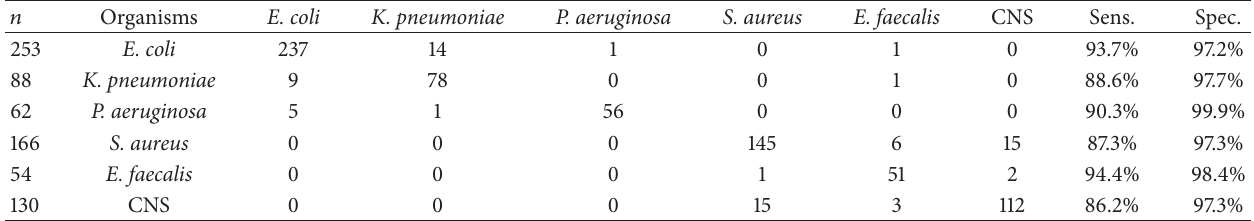
Table 4: Sensitivity and specificity results for the identification assignment of clinical isolates using transmission models for six common bacterial pathogens.